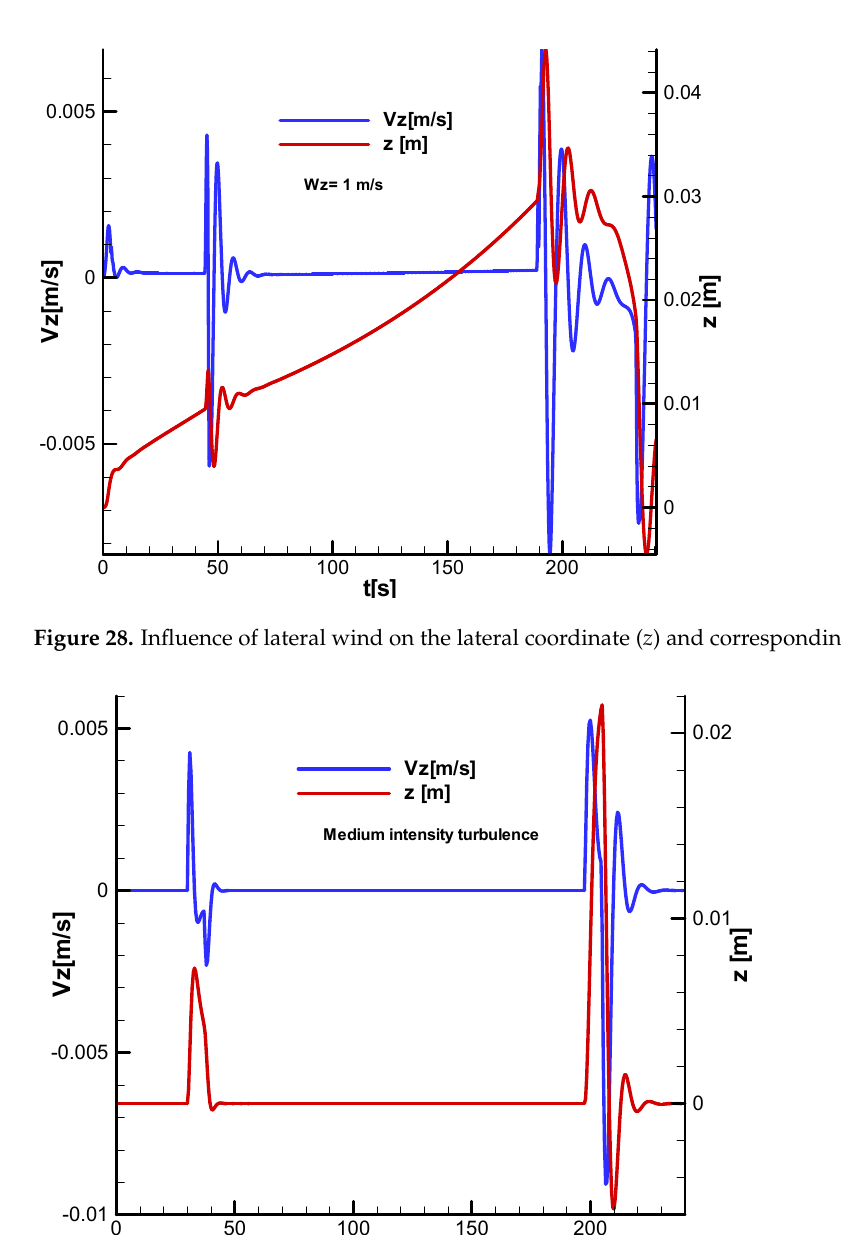
Figure 29. Influence of turbulence on the lateral coordinate ( z ) and lateral velocity ( Vz ).